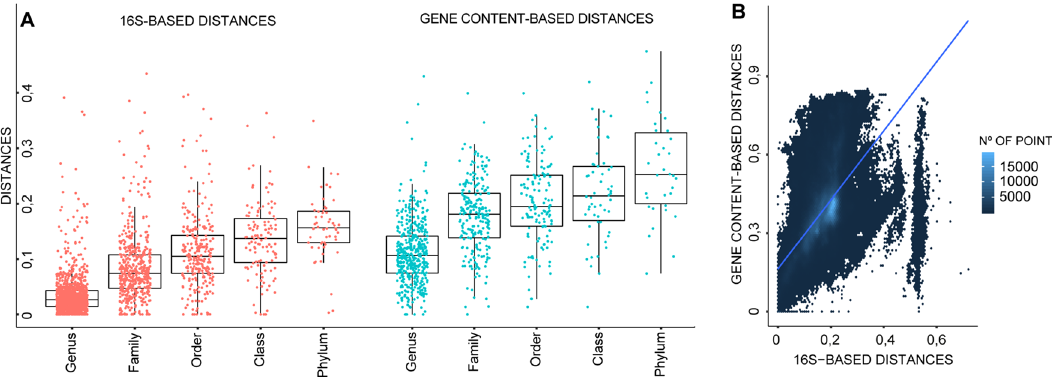
Figure 1. Panel ( A ) Box plots describing average within-group phylogenetic (16S rRNA gene sequence distance) and gene-content (pairwise Jaccard distance) distance values for each of the proposed taxa in all considered ranks. Panel ( B ) Correlation between 16S rRNA gene and gene content-based distances. Each point represents both distance values for each of the possible pairwise comparisons among the 6,989 dereplicated genomes with genome annotations (y = 1.32x + 0.16, R 2 =